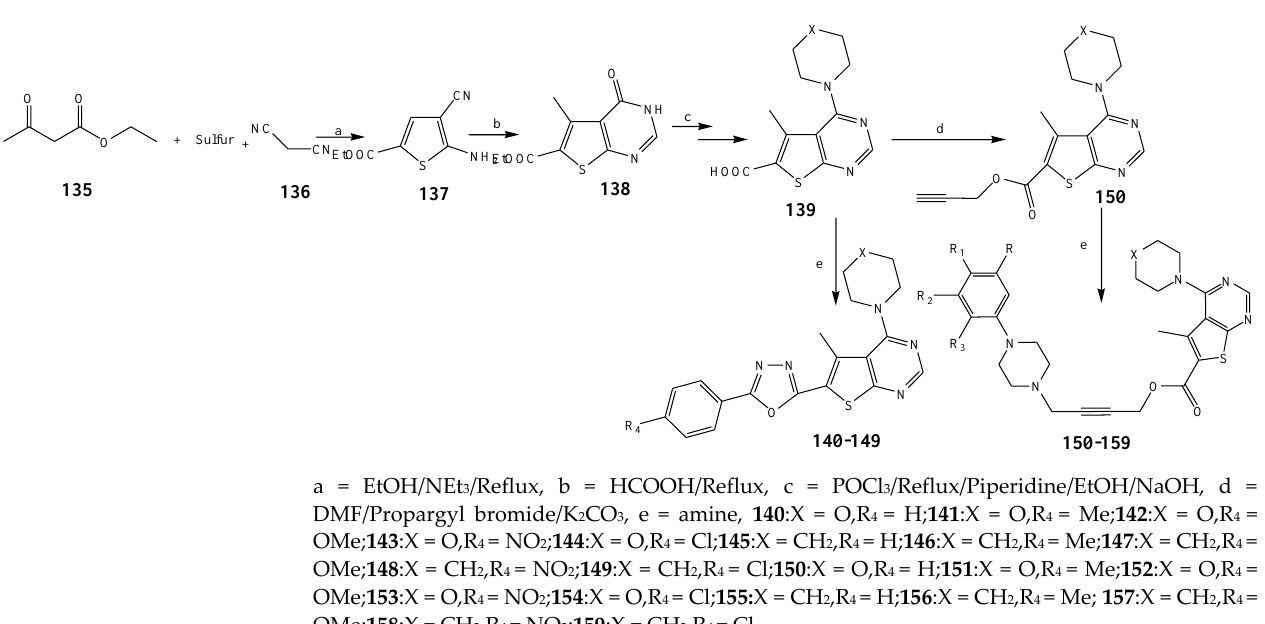
OMe; 153 :X = O,R 4 = NO 2 ; 154 :X = O,R 4 = Cl; 155: X = CH 2 ,R 4 = H; 156 :X = CH 2 ,R 4 = Me; 157 :X = CH 2 ,R 4 =